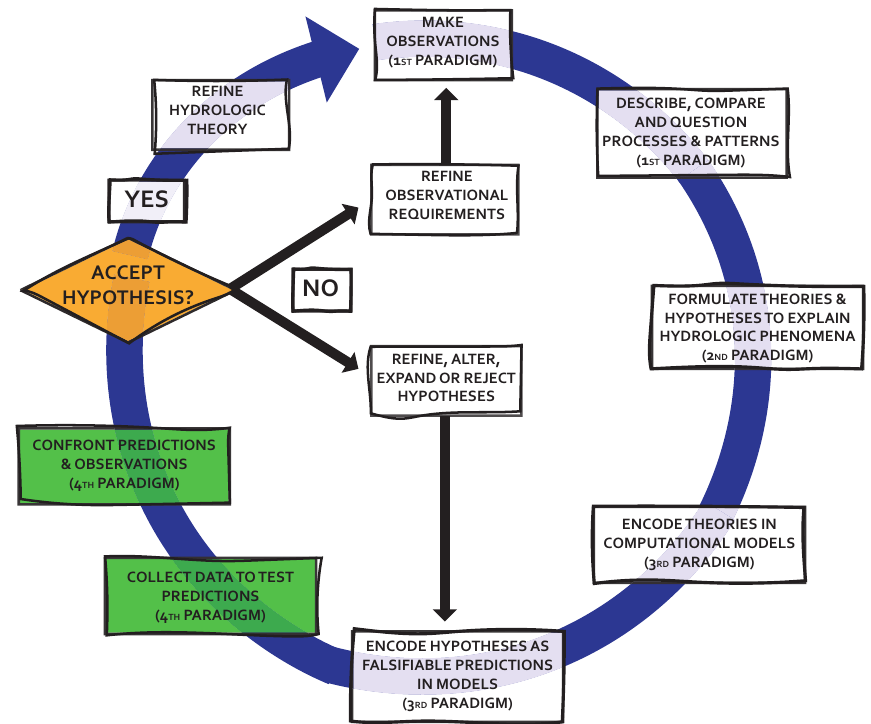
Figure 1. An illustration of the scientific method in hydrology, highlighting how each component of the method reflects the various paradigms of science. The fourth paradigm is characterized by advanced data collection and analysis, as noted in the green boxes. Based on Fig. 1 in Clark et al.